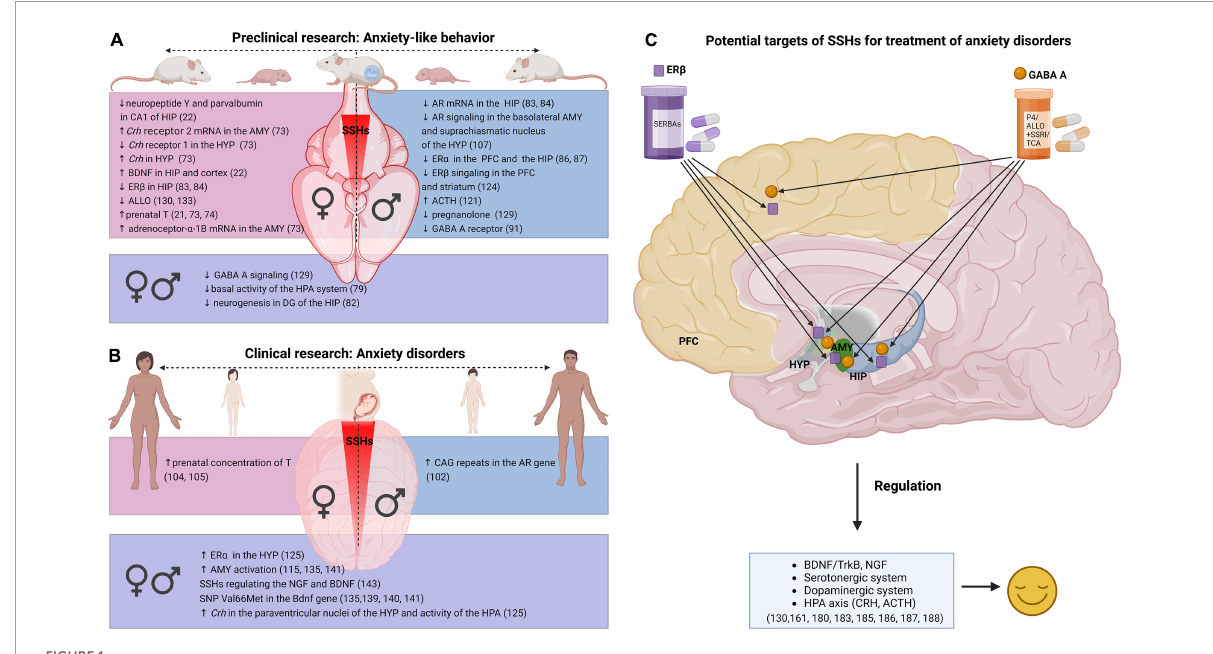
FIGURE1 Relationship between SSHs and anxiety in research. (A) Dysregulation related to SSHs in anxiety-like behavior—preclinical research, (B) dysregulation related to SSHs in anxiety disorders—clinical research, (C) treatment approaches for anxiety disorders in adult women and men (Created with BioRender.com). SSHs (sex steroid hormones), AMY (amygdala), Crh (Corticotropin-releasing hormone), HYP (hypothalamus), BDNF (Brain-derived neurotrophic factor), TrkB (tropomyosin receptor kinase B), HIP (hippocampus), HPA (hypothalamic-pituitary-adrenal axis), ER β (estrogen receptor β ), ER α (estrogen receptor α ), ALLO (allopregnanolone), GABA A (Gamma-aminobutyric acid A receptor), T (testosterone), AR (androgen receptor), DG (dentate gyrus), PFC (prefrontal cortex), ACTH (adrenocorticotropin hormone), SNP (single nucleotide polymorphism), NGF (nerve growth factor), P4 (progesterone), SERBAs (selective estrogen receptor β agonists), SSRI (selective serotonin reuptake inhibitors), TCA (tricyclic